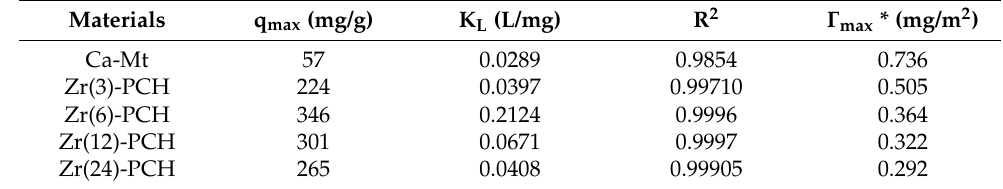
Table 4. Langmuir model parameters obtained from the fitting of experimental data for different Zr(X)-PCH